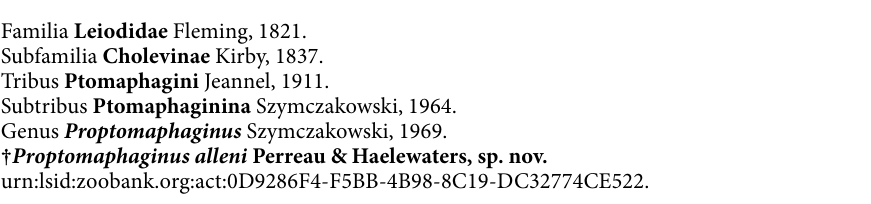
DO1468K); female specimen, MP031 (FH); female specimen, MP033 (SMNS: DO489K).